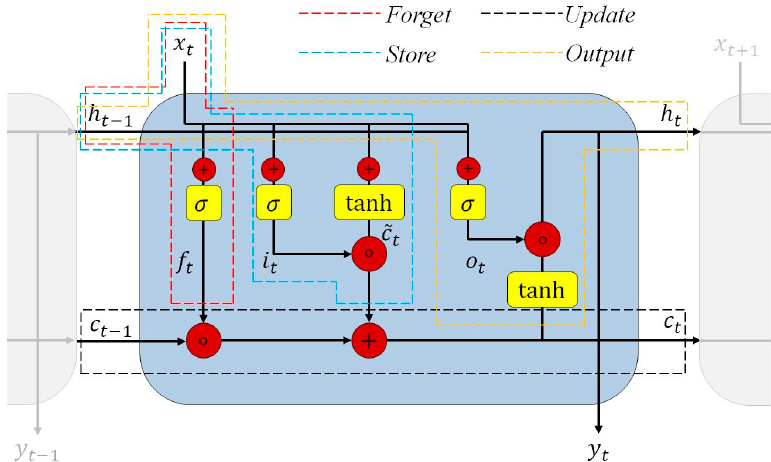
Figure 2. The repeating module of a standard long short-term memory (LSTM) model.